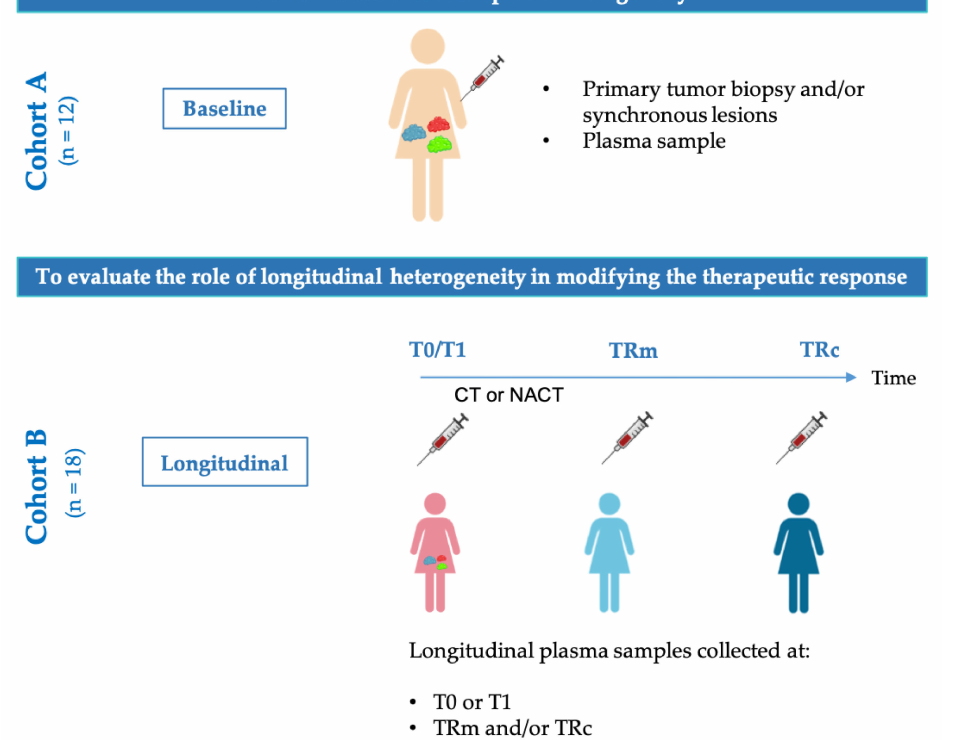
Figure 1. Study overview. The study is mainly subdivided into two different sections focused on defining the extension of spatial (cohort A, n = 12) and temporal (cohort B, n = 18) heterogeneity in HGS-EOC patients. CT, chemotherapy. NACT, neoadjuvant chemotherapy, T0, time of diagnosis. T1, first time point after diagnosis. TRm, time of molecular recurrence. TRc, time of clinical